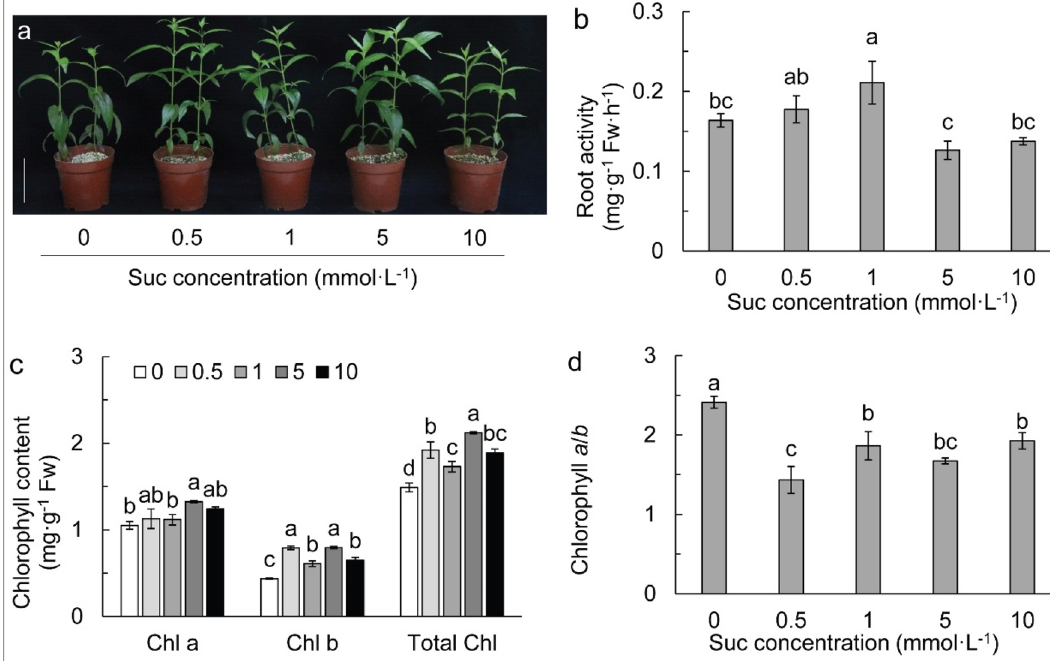
Figure 1. Plant phenotype ( a ), root activity ( b ), and chlorophyll ( c , d ) in different sucrose concentrations. Scale bar 10 cm in ( a ). Data refers to means ± SE ( n = 4). Bars with the same letter are no statistically significantly difference at P < 0.05 by Duncan’s new multiple range